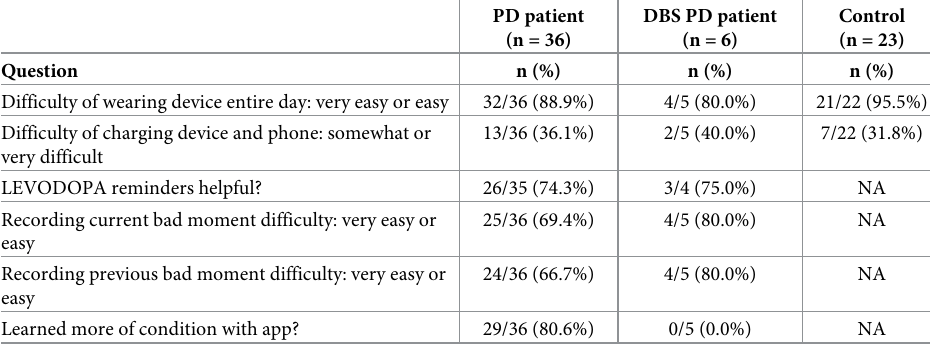
Table 2. Usability of wearables and mobile application.